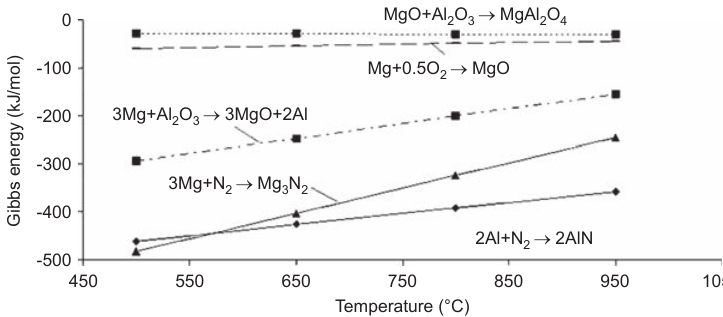
Figure 7 Changes of standard Gibbs free energy with temperature (calculated by FactSage with SGTE and FACT